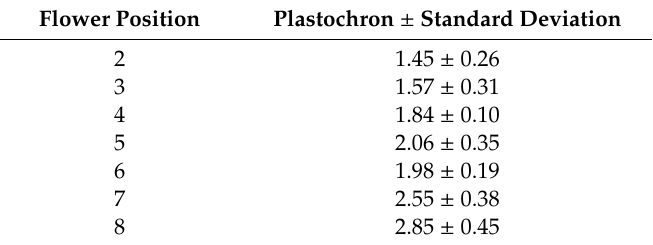
Table 1. The average cyme plastochron (in days) vs. flower position in tobacco. Data of corolla length used to calculate the cyme plastochrons were collected from the six plants in Group 1 (12 cymes) with a photoperiod cycle of 9-h light and 15-h dark. A corolla reference length of 3.0 cm was used in the calculation of these seven cyme plastochrons.